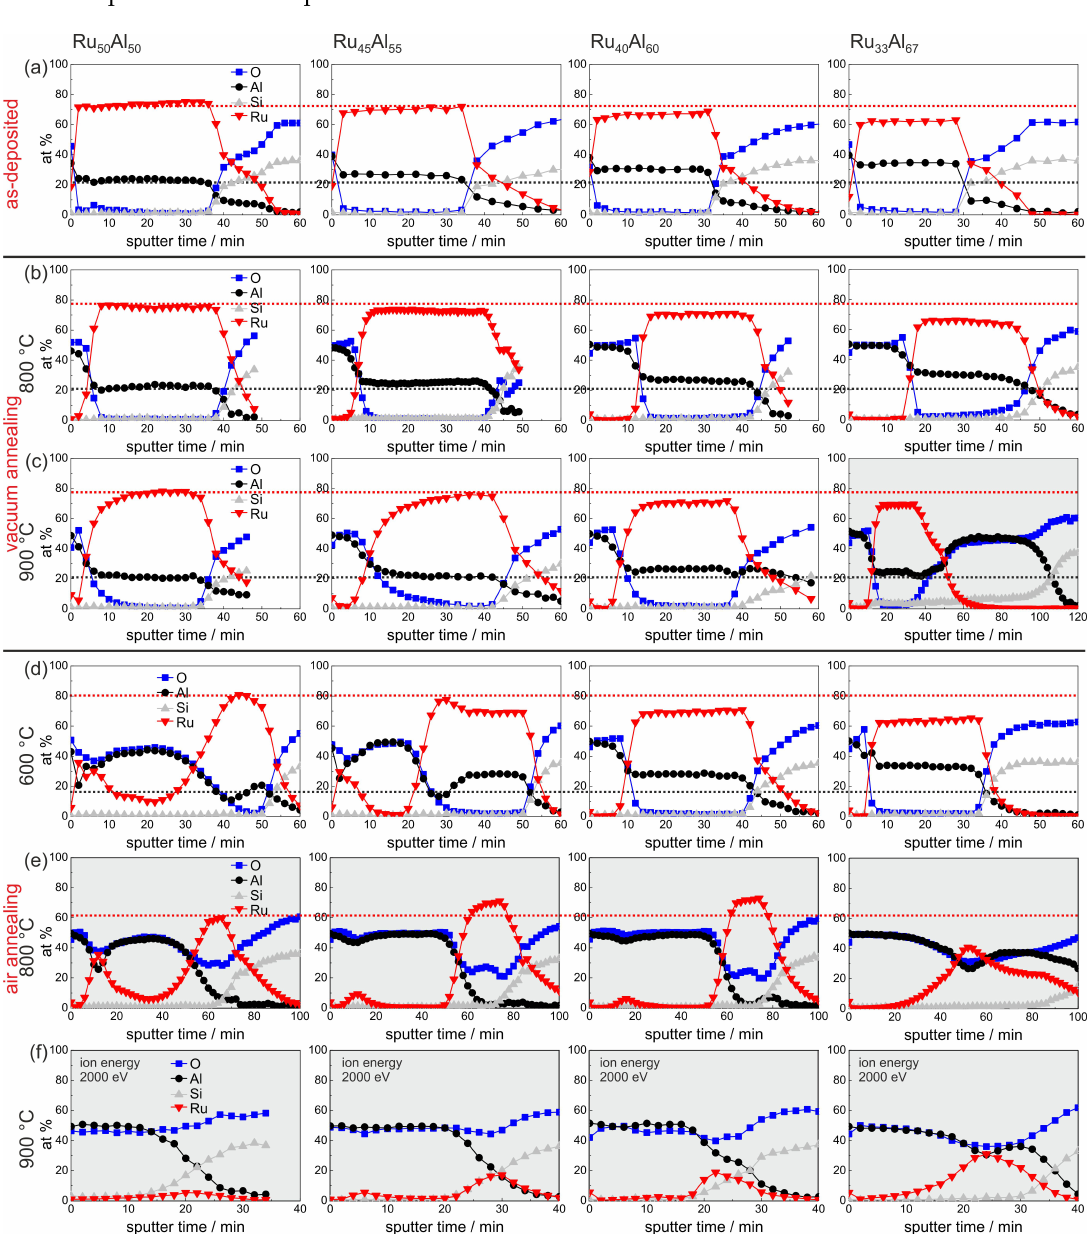
Figure 7. Overview summary of the AES measurements of the samples with the different compositions Ru 50 Al 50 , Ru 45 Al 55 , Ru 40 Al 60 and Ru 33 Al 67 ( a ) after preparation and after heat treatment for 10 h at ( b ) 800 ◦ C; ( c ) 900 ◦ C under high vacuum, as well as ( d ) 600 ◦ C; ( e ) 800 ◦ C; and ( f ) 900 ◦ C in air. The red (black) dotted lines mark the Ru (Al) content in the reference Ru 50 Al 50 sample to visualize the difference to the other samples. The majority of the measurements is scaled for a sputtering time of 60 min, and the others are marked with the light gray background. Different sputtering conditions are remarked upon where they are